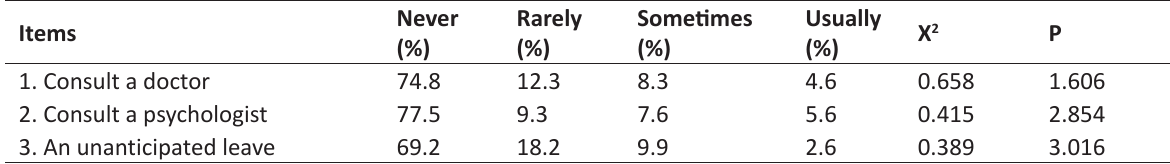
Table 5. The different items of health repercussions Items